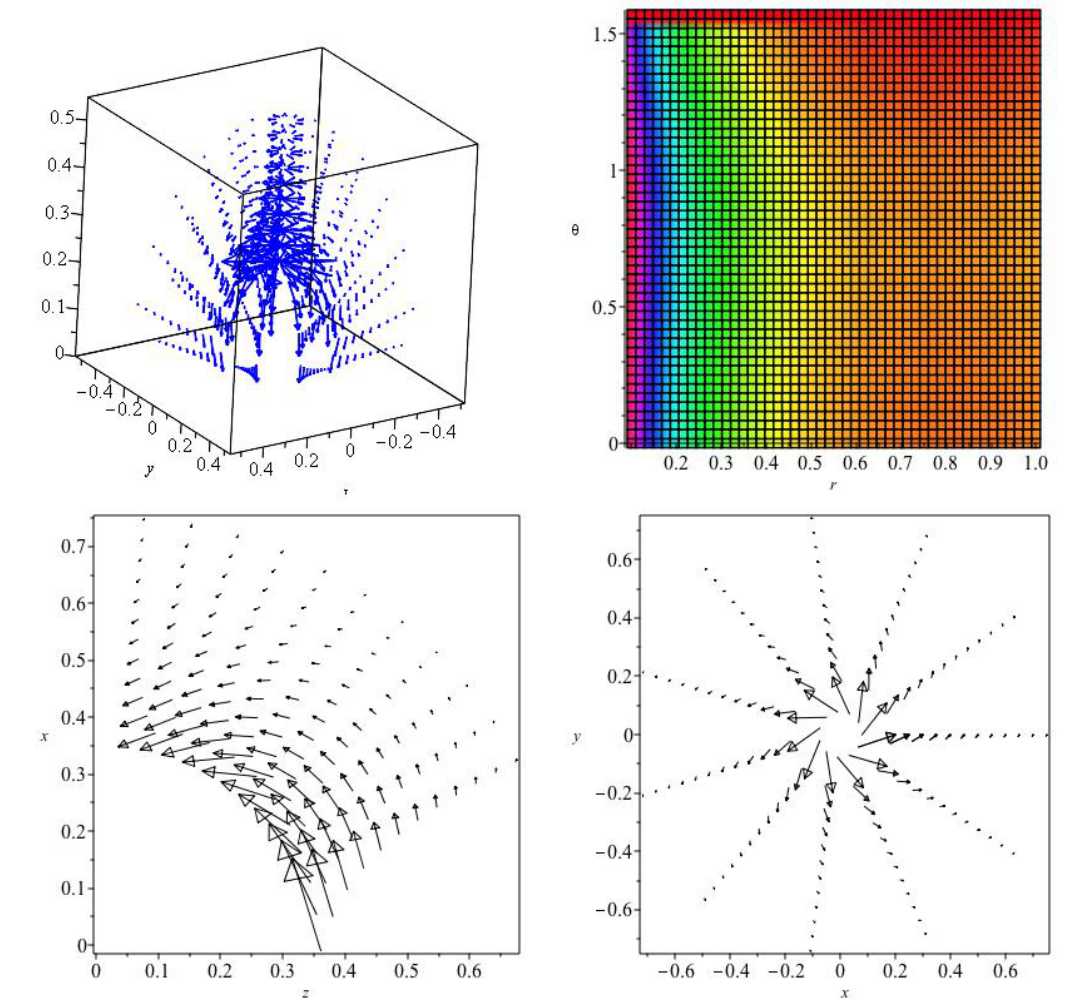
Figure 3. At upper left we show a three dimensional set of field vectors for the parameter set { C 1, C 2, C 3, C 4 } = { 5,5,5,1 } , which set applies to all of the panels in this figure. The radius runs only from 0.25 to 0.55 at upper left in order to show inner and outer features. At upper right we show the vertical current function. It declines in radius from the axis by about a factor 2 at θ ≈ 0.75, but there are lower regions near the equator and near the axis for r > ≈ 0.5. The panel at lower left shows vectors in the poloidal plane with the z axis horizontal. The radius runs only from 0.35 to 0.75. Near the axis the field becomes nearly toroidal due to the strong axial current. The circulating field appears in the figure at lower right at small radius, although the radius runs from 0.2 to 0.75. This is actually the radius along the cone with opening angle 30 ◦ projected along the polar axis onto the equatorial plane. Hence the radius along the cone is twice as large as that